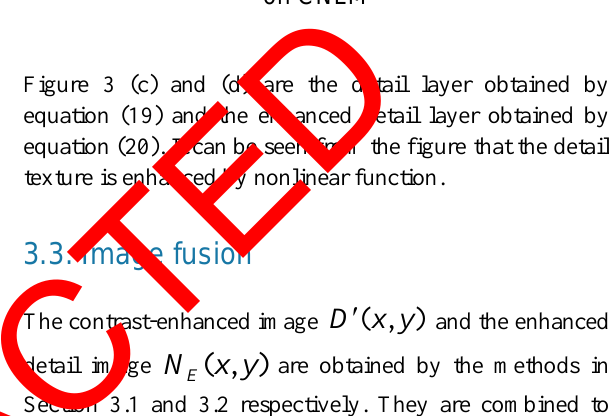
Figure 3. Enhancement of image detail layer based on